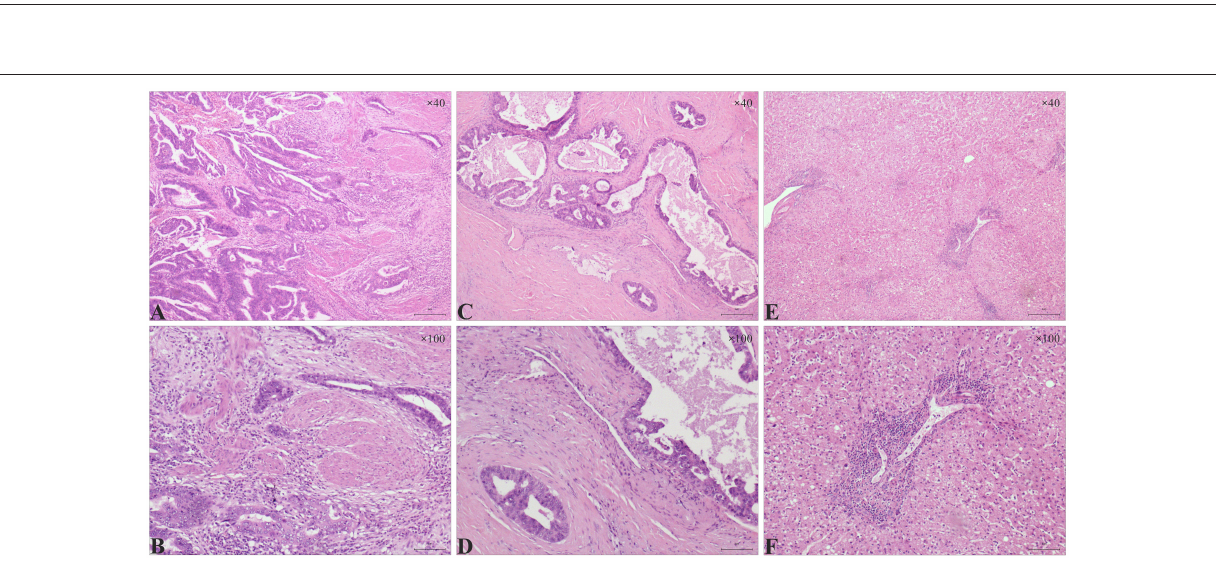
FIGURE 3 | Histologic features in gallbladder adenocarcinoma and liver sections. (A, B) Stromal infiltration of gallbladder adenocarcinoma. (A) Atypical glands were observed in a low to moderately differentiated gallbladder adenocarcinoma (A , H&E , × 40 ) . (B) Distorted glands invaded the muscularis propria layer of the gallbladder (B , H&E, × 100 ) . (C,D) Vascular invasion in gallbladder adenocarcinoma. (C) part of the dysplastic glands were sieve-like with mucus (C , H&E, × 40 ) . (D) Dysplastic glands invaded the vascular walls (D , H&E, × 100 ) . ( E,F) A large number of lymphocytes infiltrated in the portal area of the liver; milder hepatic steatosis was observed in some areas (E , H&E, × 40; F , H&E, × 100 )